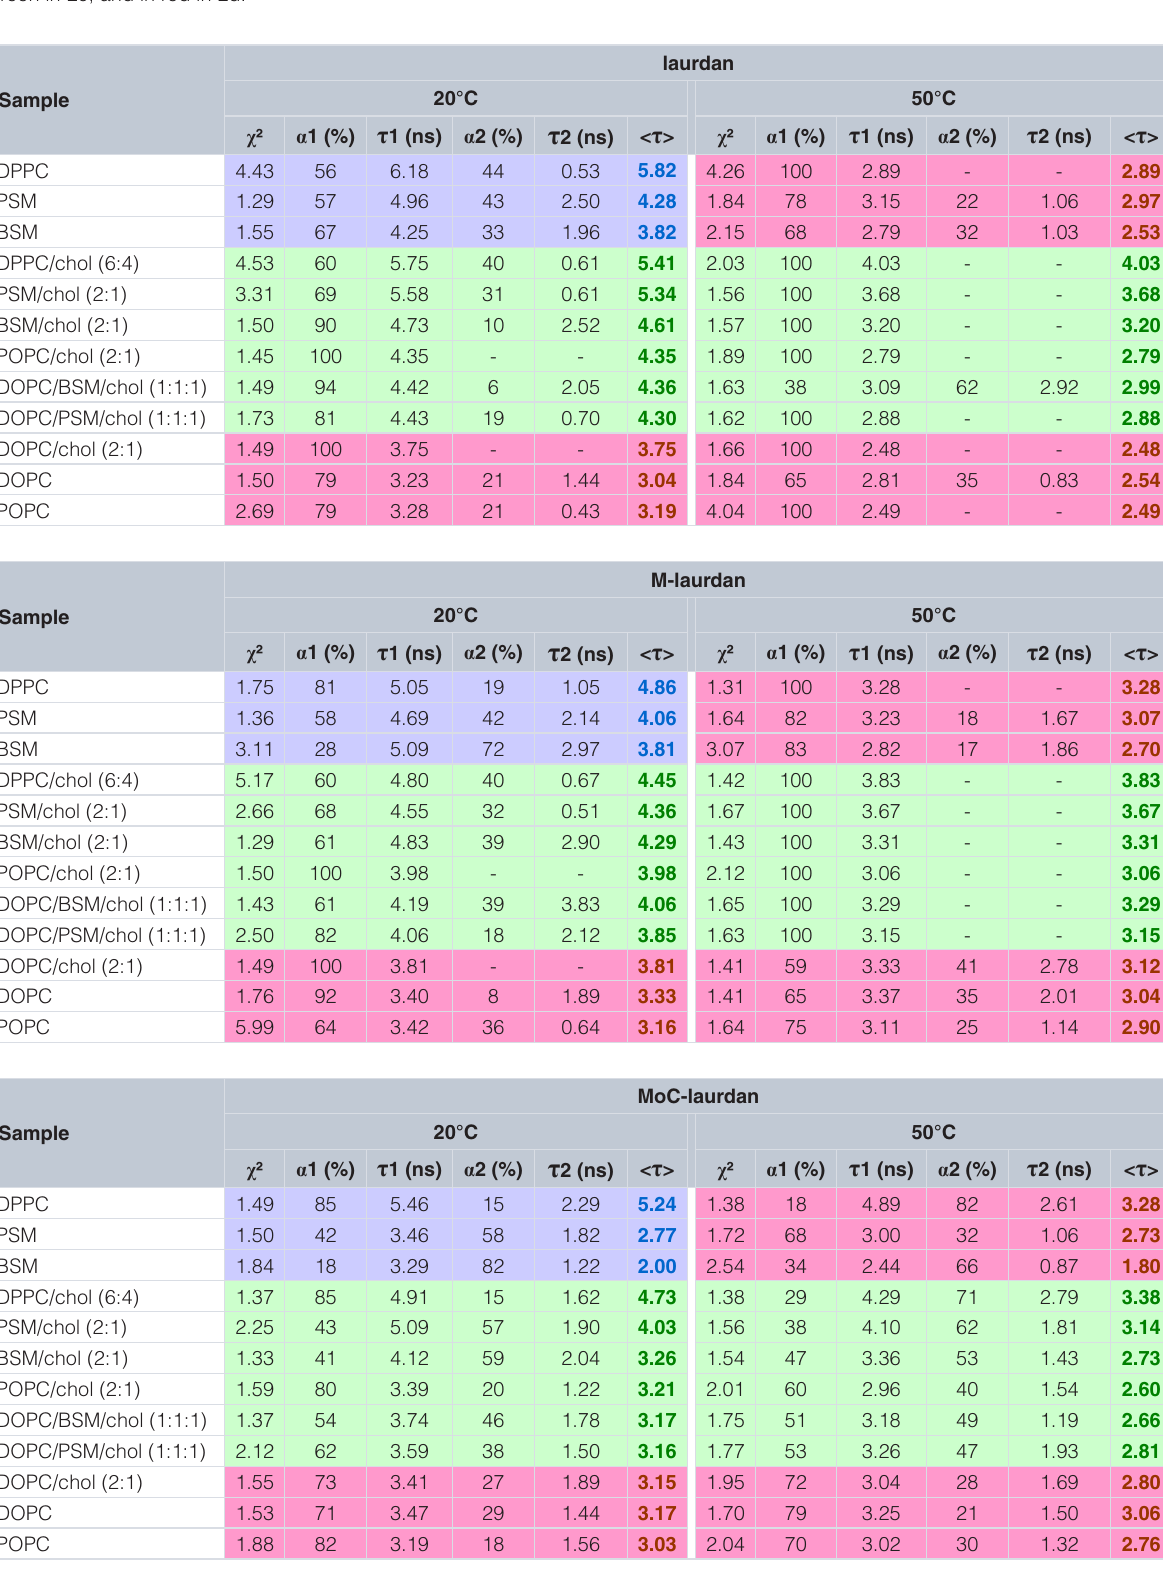
Table 3. Lifetimes measured for dyes in various lipid environments at 20°C and 50°C (excitation 380 nm, lifetimes recorded at 460 nm, POPOP used as reference, τ =1.35 ns in ethanol). In the table, the lines in blue correspond to bilayers in So phase, in green in Lo, and in red in